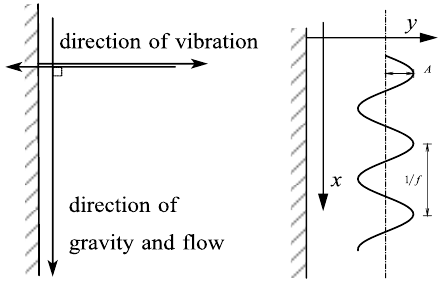
Figure 1. Vibration direction and vibration type.